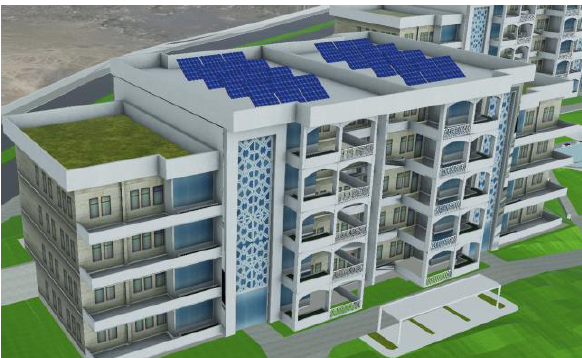
Figure 4. A sample view of generated textured buildings from Bizimsehir (www.bizimsehir.org).